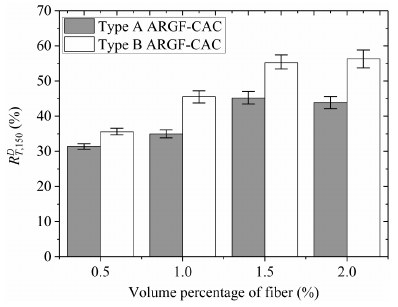
Figure 17. Variation of D T R 150, with fiber content.